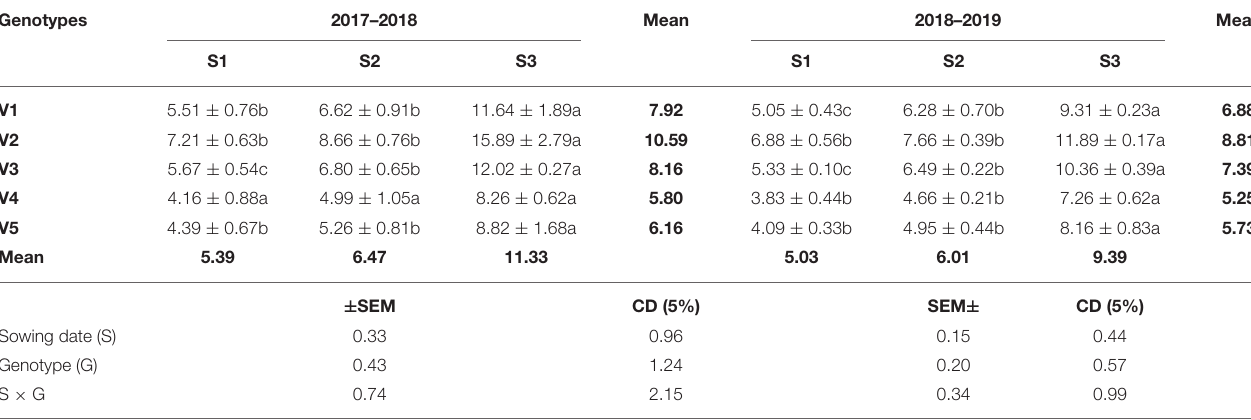
TABLE 1 | Hydrogen peroxide content ( µ mol g − 1 fresh weight) at mid-flowering stage in top leaf of mustard varieties sown at three different dates during rabi 2017–2018 and 2018–2019. Genotypes